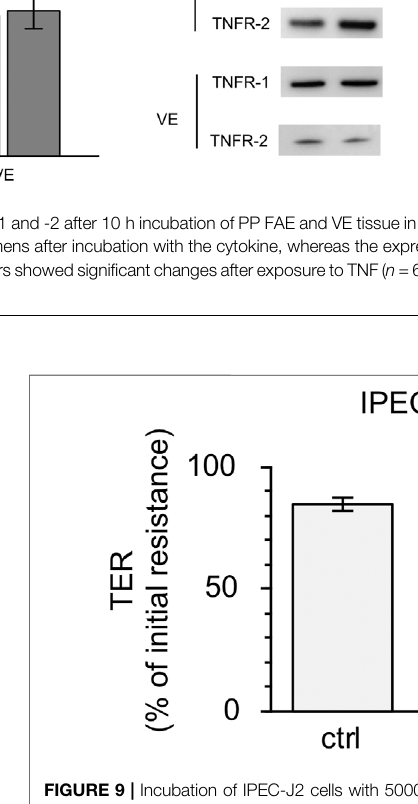
FIGURE 9 | Incubation of IPEC-J2 cells with 5000 U/ml TNF for 10 h. The cytokine was added to the basolateral compartment of the cell inserts. A marked decrease in TER, comparable with results seen in PP tissue specimens, was observed ( n = 23, ** p < 0.01).